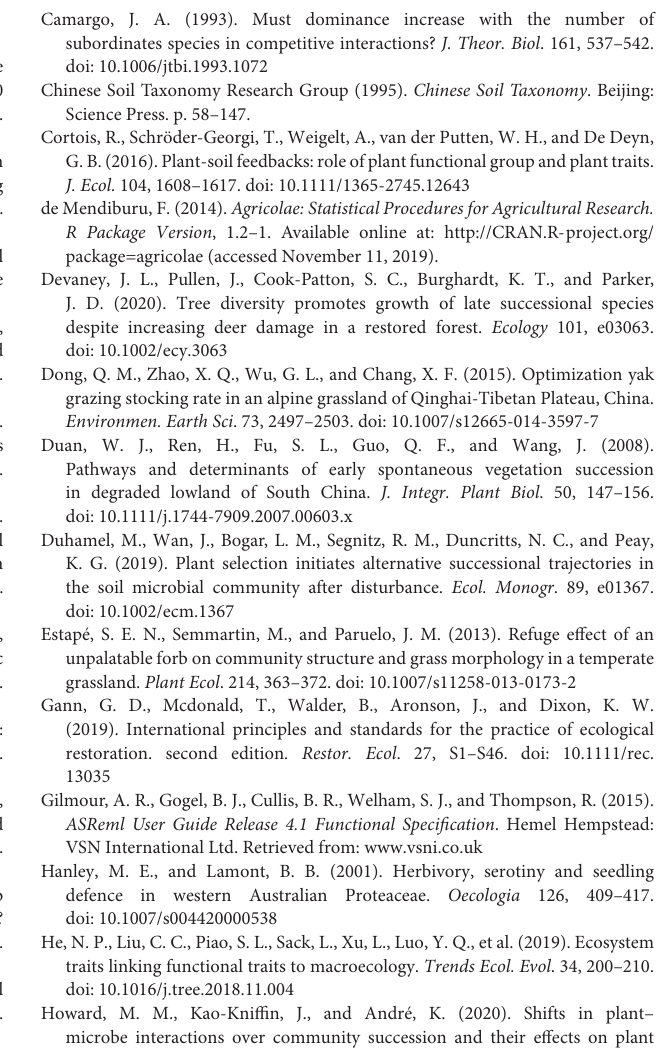
Supplementary Figure S1 | (a,b) The cluster dendrogram of sample plot. Supplementary Figure S2 | Correlations among variables of plant, soil properties and ecosystem coupling and multifunctionality in each succession stage, respectively. The value in the square represents the value of the correlation coefficient. ∗ , ∗∗ , and ∗∗∗ show the significant correlations at 0.05, 0.01, and 0.001 levels. SR, plant species richness; EV, Camargo evenness index; PGI, plant growth index; SCI, soil carbon accumulation index; SNI, soil nutrient index; EMF, ecosystem multifunctionality index; EC_SP, extent of ecosystem coupling (soil-plant); AGB, aboveground biomass; BGB, belowground biomass; PD, plant density; PH, plant height; SBD, soil bulk density; SM, soil moisture; ST, soil temperature; STC, soil total carbon; STN, soil total nitrogen; STP, soil total